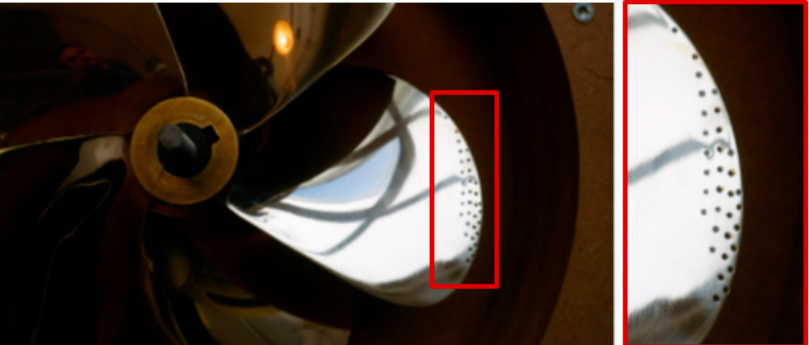
Figure 7. Princess Royal “Modified Propeller”.